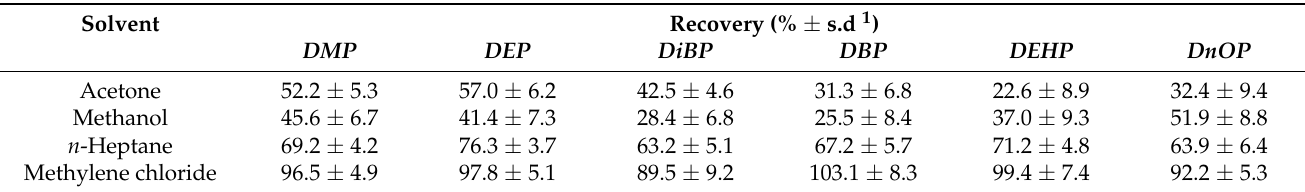
Table 3. Mean recoveries (%), along with standard deviation of the seven investigated PAEs from the C 18 cartridge by means of different organic solvents. For acronyms: see Table 1.